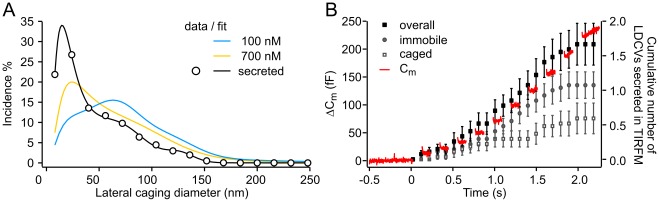
Secreted vesicles were immobile immediately before fusion.(A) Histogram of the averaged lateral CD distribution of secreted vesicles from cells at a pre-stimulus [Ca2+]i of 590 nM (black). Data points are represented by circles, whereas solid lines represent the best fit by a single log-normal and two Gaussian components. Cells were stimulated by a train of ten depolarizations (5 Hz) 10 s before the end of the imaging period. The CD values were calculated from the last 15 s prior to fusion. The two fits obtained from cells kept at 100 nM (blue) and 700 nM (orange) [Ca2+]i were plotted for comparison. (B) Average secretion of 19 cells stimulated 1 to 2 times. The increase in membrane capacitance is shown in red and the averaged cumulative number of exocytotic events visualized by TIRF-microscopy in black. The type of mobility of these LDCVs prior to secretion is indicated by grey filled circles (immobile) and grey empty boxes (caged). All curves were aligned to the onset of the stimulus. N100nM/n: 23/719; N700nM/n: 14/309; Nsecreted/n: 19/53.